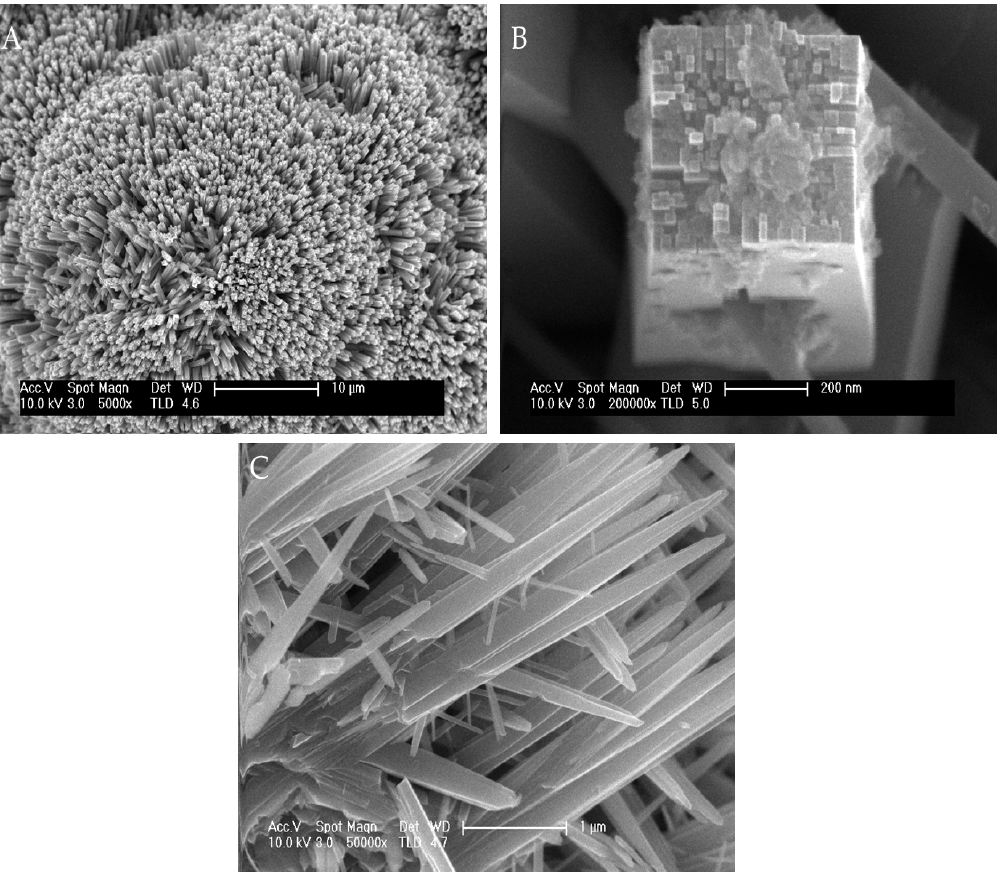
Figure 1. Field emission scanning electron microscopy (FE-SEM) images of the as-synthesized TiO 2 Nanowires (NWs) at 5000× ( A ), 20,000× ( B ), and ZnO NWs at 5000× ( C ).